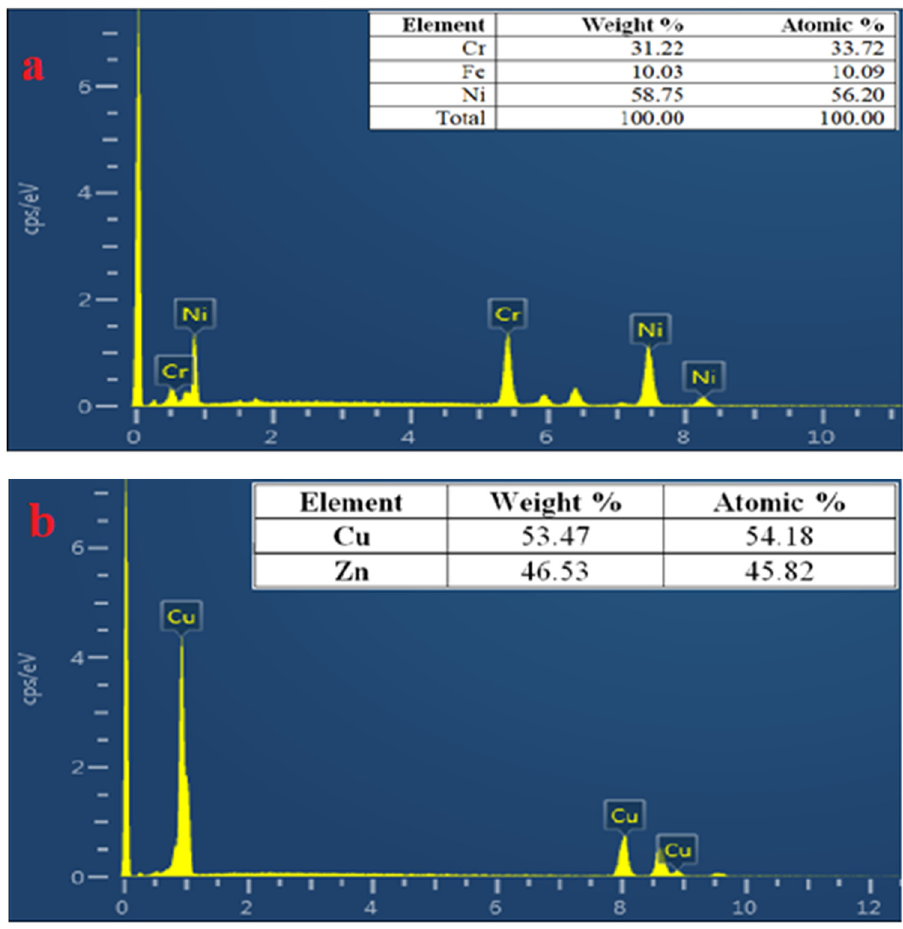
Figure 2: EDS analysis of ( a ) Inconel 690 and ( b ) fresh